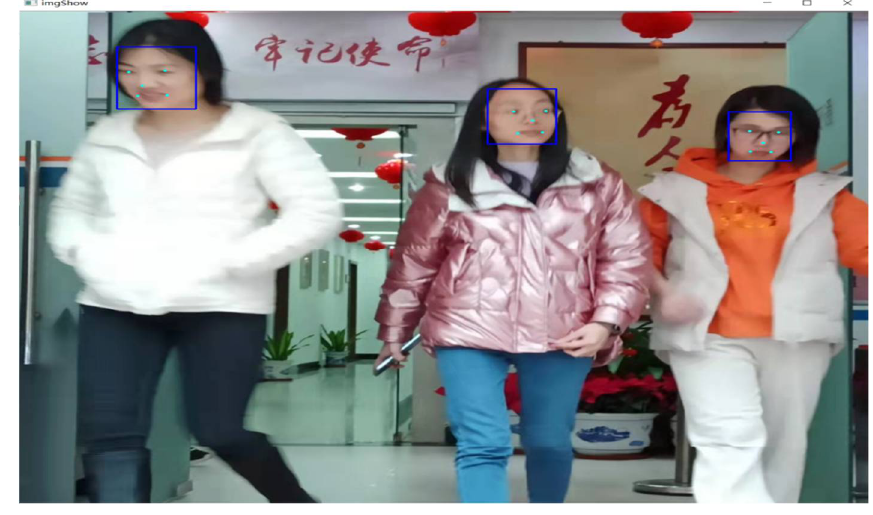
Figure 11. Multiple faces are extracted.